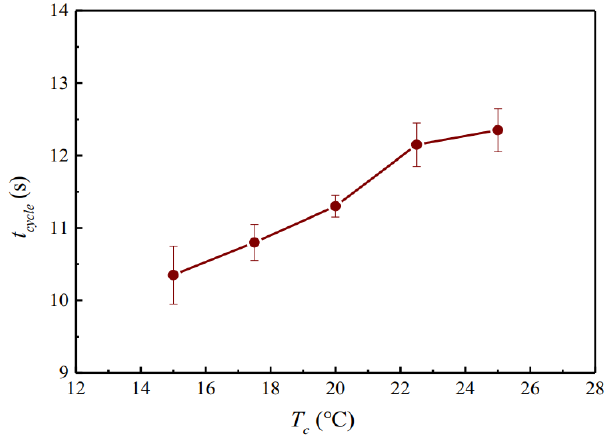
Figure 14. Measured period at di ff erent cooling temperatures.